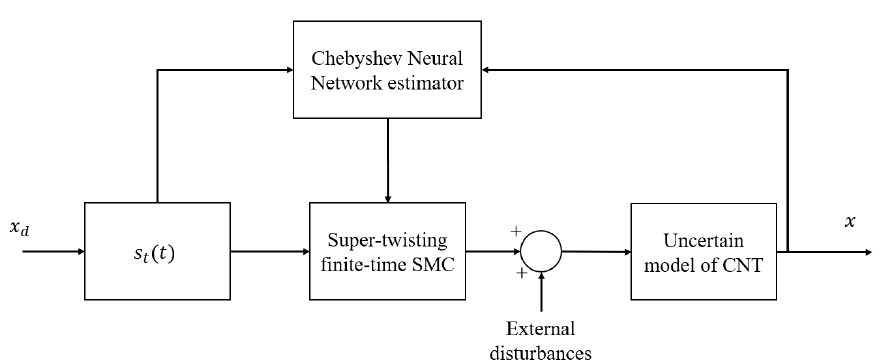
Figure 3. The block diagram of the proposed control scheme.